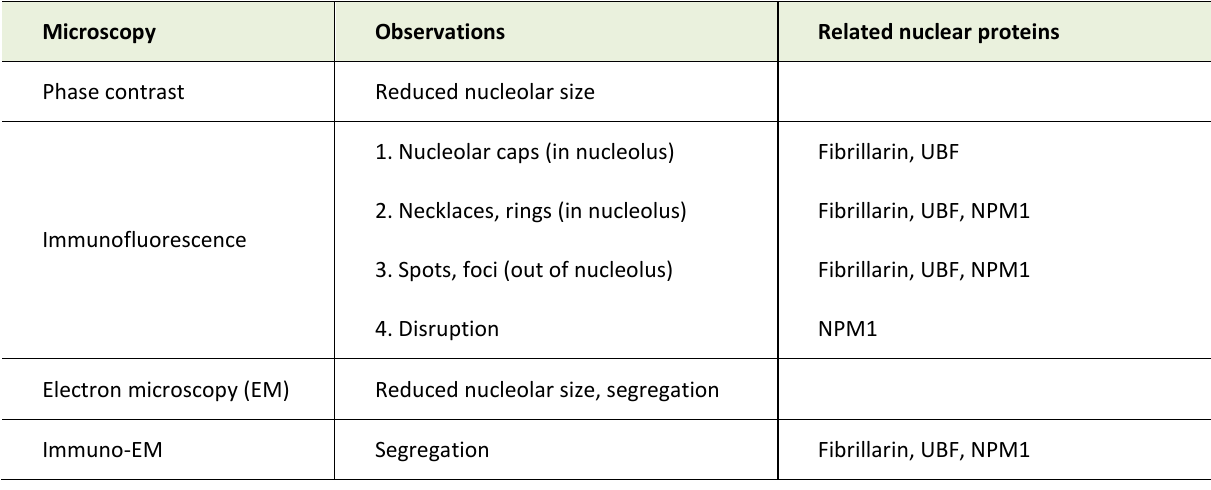
TABLE 1. Morphology upon nucleolar